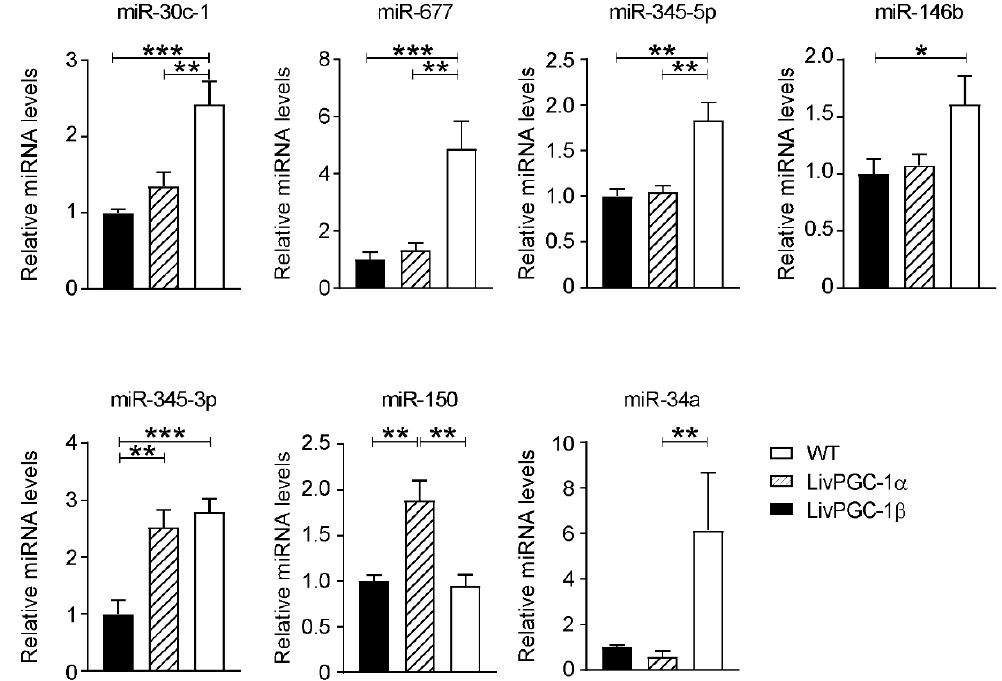
Figure 3. Real-time quantitative polymerase chain reaction (RT-qPCR) validation of hepatic microRNAs di ff erentially modulated by overexpression of PGC-1 α or PGC-1 β specifically in the liver. Relative mRNA expression of microRNAs from liver samples collected from LivPGC-1 α and LivPGC-1 β mice compared to wild-type (WT) controls. All animals were sacrificed after overnight fasting. The data were normalized on the geometrical mean (“best-keeper” gene) of sno202 and sno234 levels, presented as relative expression values, and plotted as means ± standard error of the mean (SEM). Comparison of di ff erent groups ( n = 6 mice / group) was performed using One-way ANOVA followed by Tukey’s test for multiple comparison. A p -value of 0.05 was considered significant (* p < 0.05; ** p < 0.01; *** p < 0.001).